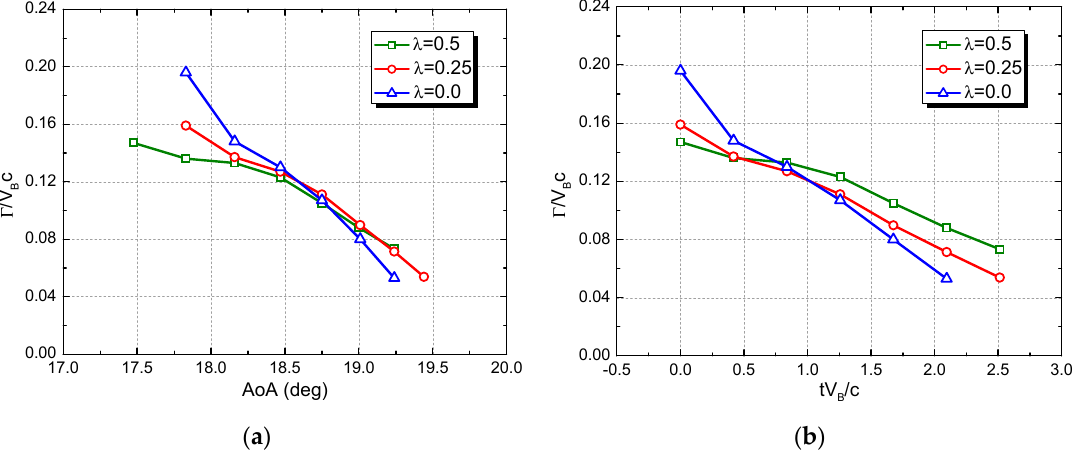
Figure 21. Comparisons of TEV dissipation between different oscillating velocities. ( a ) Variation with AoA. ( b ) Variation with time.